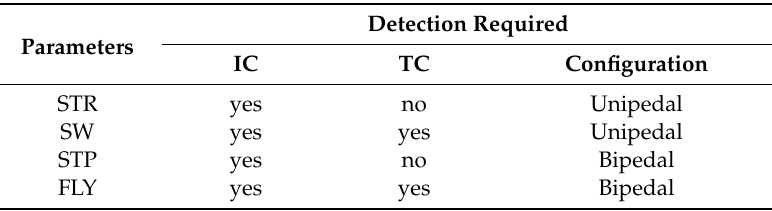
Table 1. Features and configurations required in order to estimate, for each step / stride, the parameters used to detect hurdle